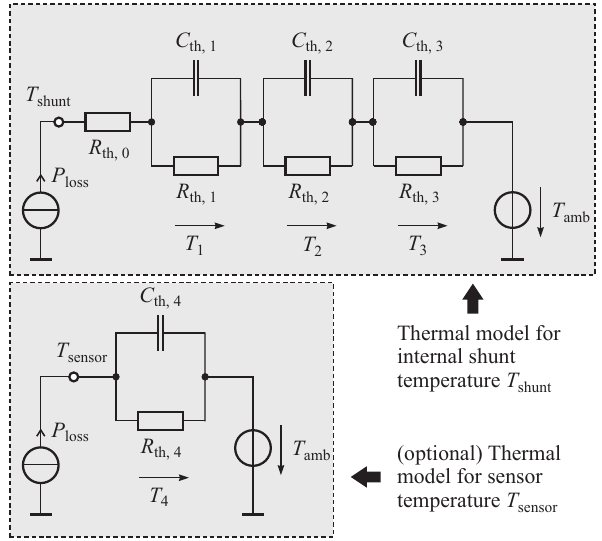
Figure 3. Thermal model used for calculation of the internal shunt temperature and the variation of the sensor temperature due to self-